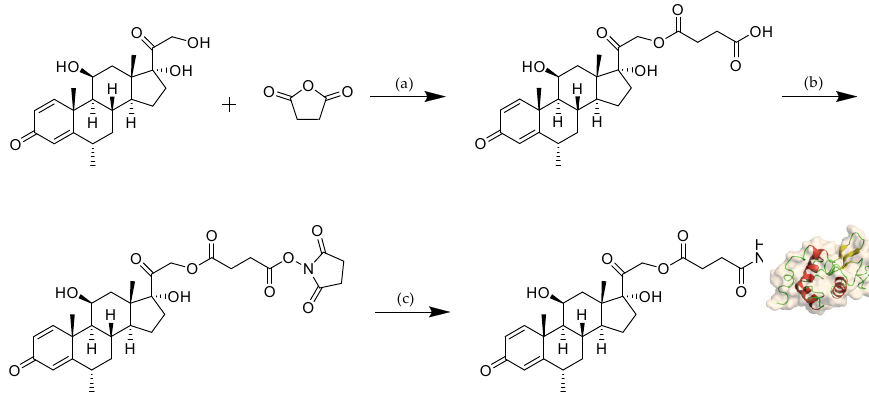
Figure 2. Reaction scheme for the synthesis of MPS–LZM. Reagents and conditions: (a) 4- dimethylaminopyridine (DMAP), pyridine, rt, overnight, 89%; (b) N-hydroxysuccinimide (NHS), N,N’-dicyclohexylcarbodiimide (DCC), Tetrahydrofuran (THF), rt, 6 h; (c) LZM, PBS (pH 7.5)/N,N- dimethylacetamide (DMA), rt, 8 h. rt: room temperature.